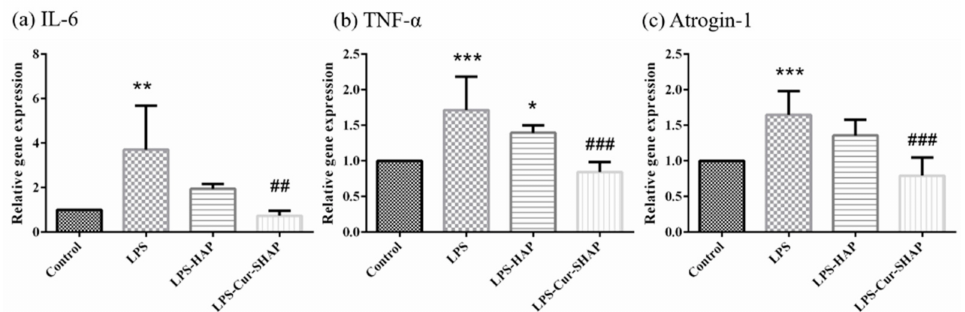
Figure 8. Gene expression of C2C12 after Cur-SHAP treatment and LPS induction for 24 h. Relative expression levels of ( a ) IL-6, ( b ) TNF- α , and ( c ) Atrogin-1 gene was measured by qPCR and normal- ized to that of GAPDH ( n = 6, * p < 0.05, ** p < 0.01, *** p < 0.001 compared with control; ## p < 0.01, ### p < 0.001 compared with LPS).